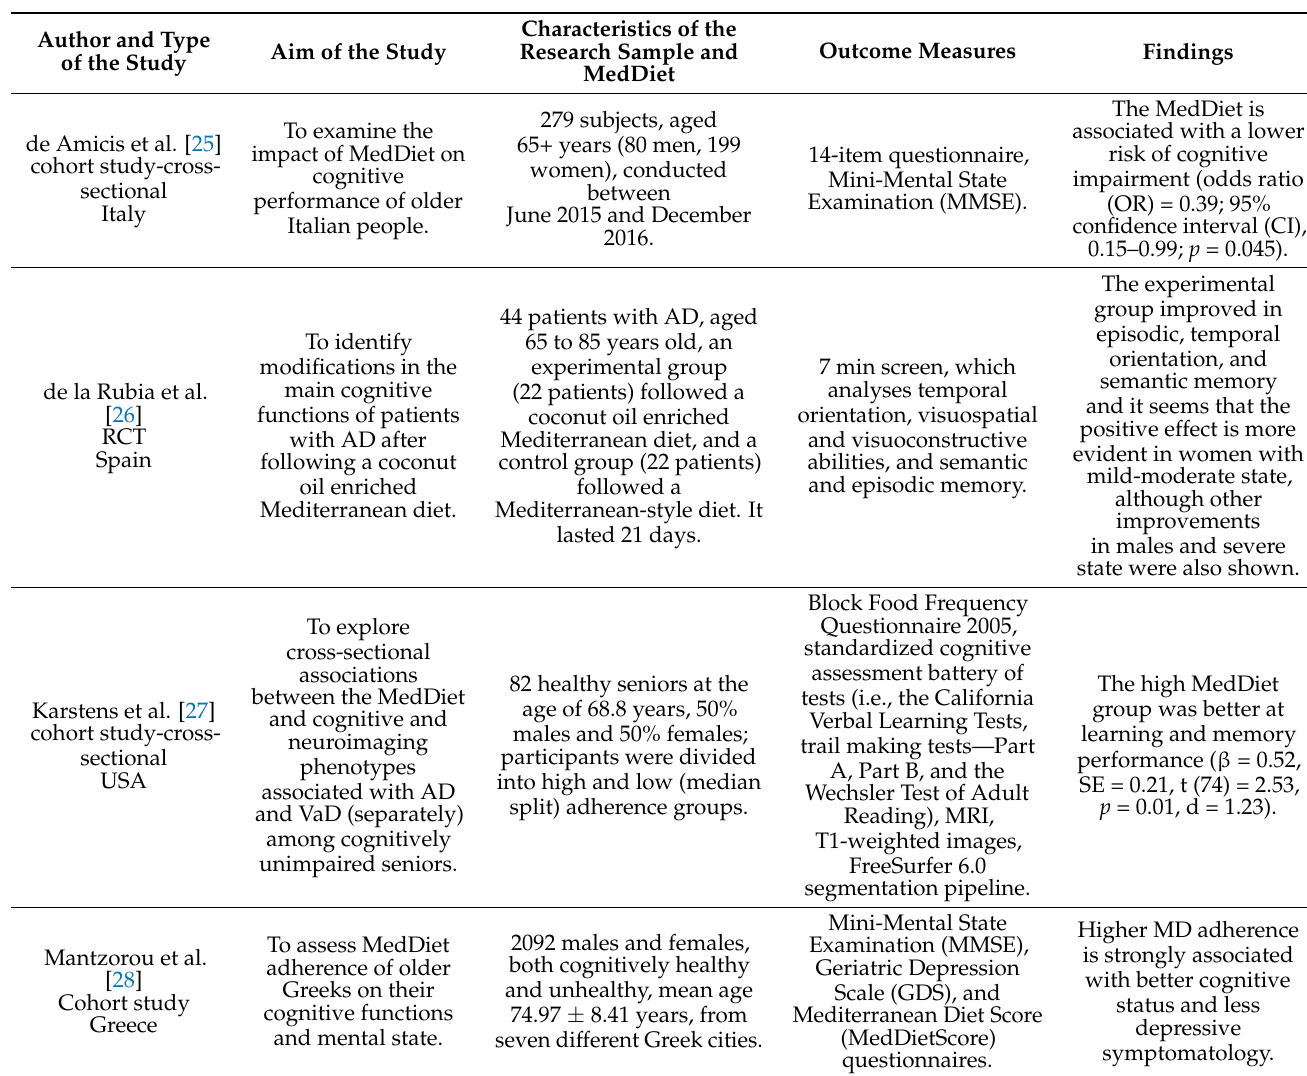
Table 1. An overview of the